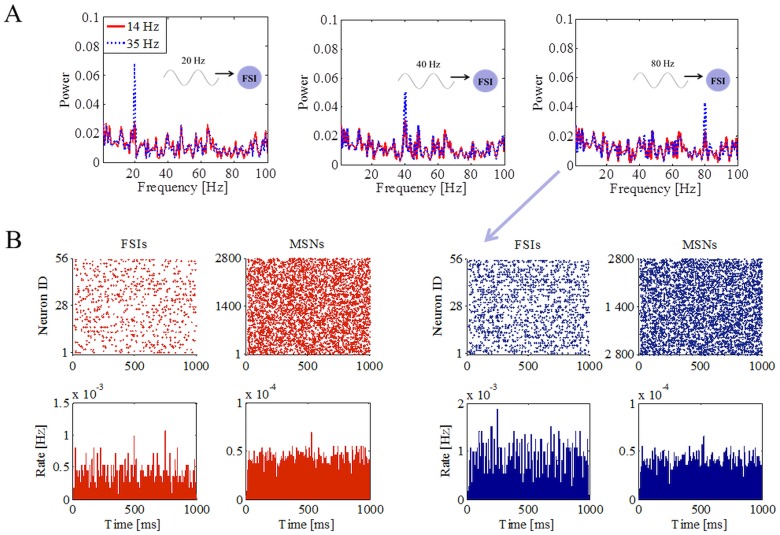
Propagation of asynchronous cortical oscillations in a striatal network model through FSIs.(A) Power spectra of the MSNs population when only FSIs were driven by cortical oscillatory inputs at 20, 40 and 80 Hz. The ability of FSIs to transfer oscillations to MSNs (blue traces) directly depended on their average firing rates. (B) Spiking activity (top) and population firing rate (bottom) of 56 FSIs and 2800 MSNs for the low (Amax = 150 pA) and high (Amax = 300 pA) maximal oscillatory amplitude onto FSIs. Population firing rate was also divided by the number of corresponding FSIs and MSNs, respectively, and the number of bins.